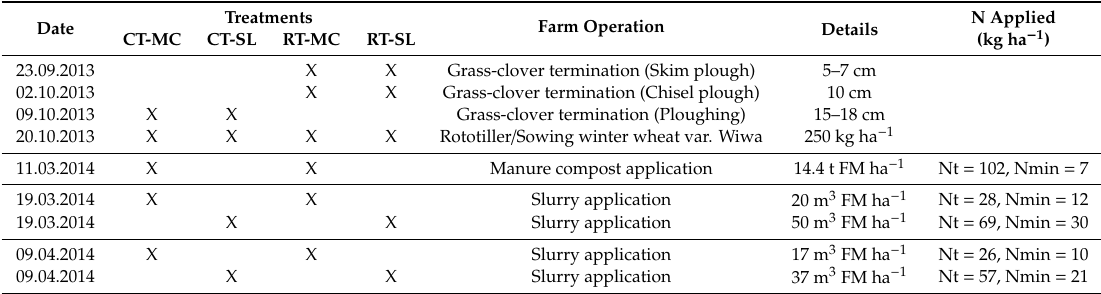
Table A2. Farm operations during wheat cropping in 2013 and 2014, according to: tillage system (conventional (CT) and reduced (RT)) and fertilization treatment (slurry (SL) and manure compost with reduced amounts of slurry